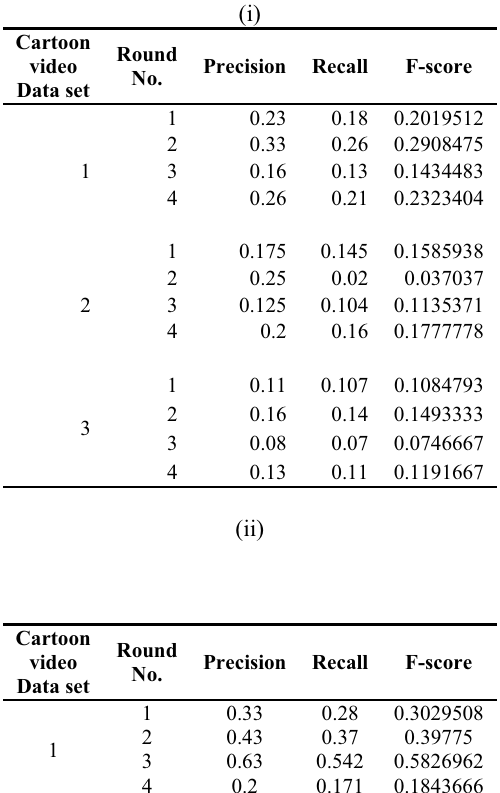
Table. 3. Precision-recall and F-score values for CBVR system (i) with Motion pattern (ii) with motion feature and RGB color model (iii) with histogram features and (iv) with extensive feature set for Cartoon